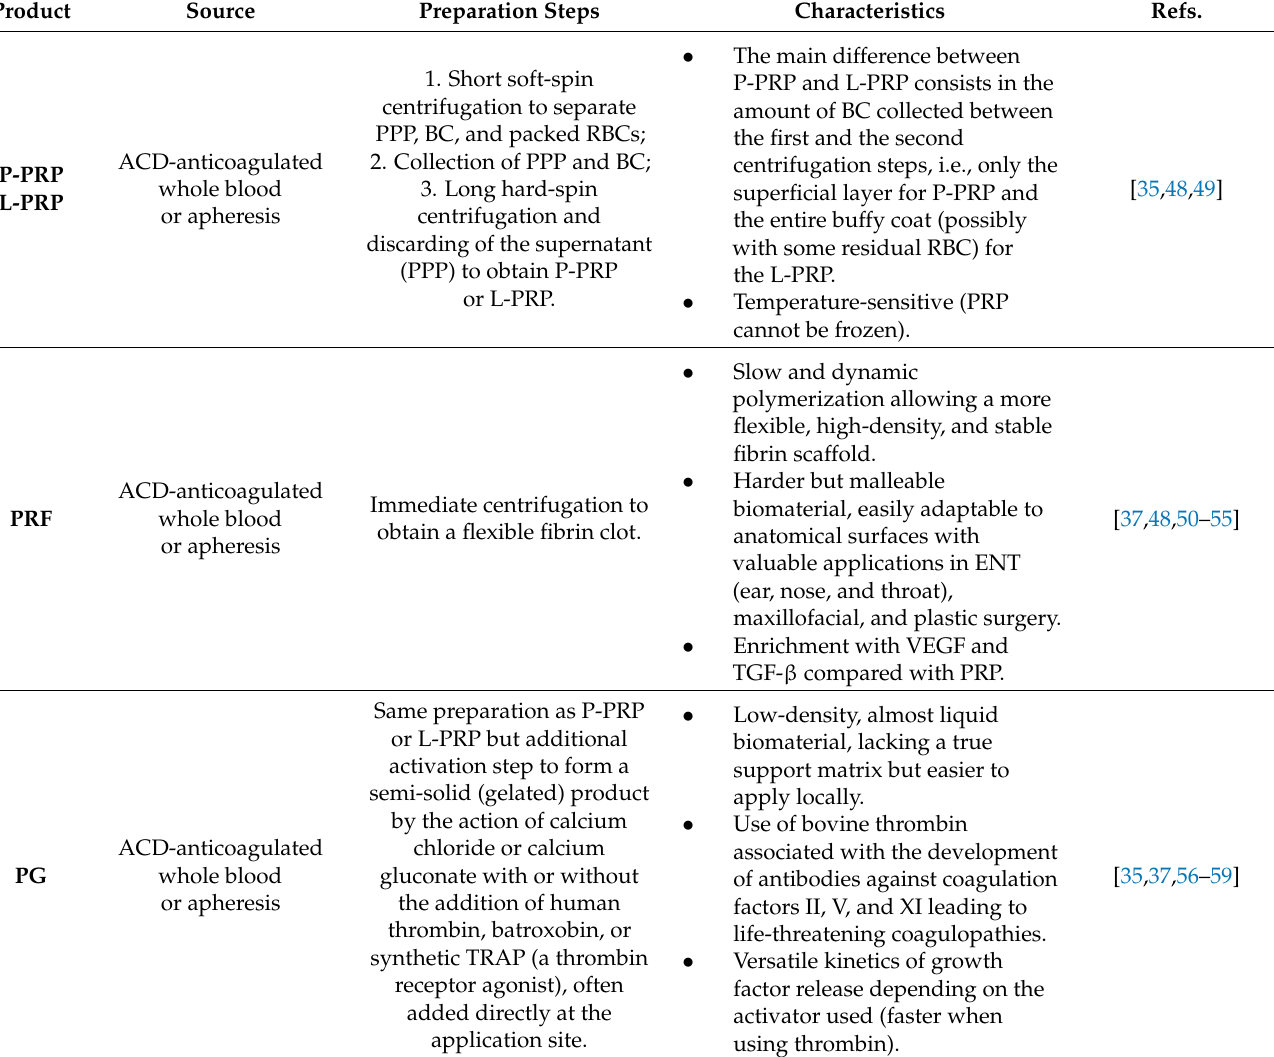
Table 2. Sources, technical preparation, and characteristics of platelet